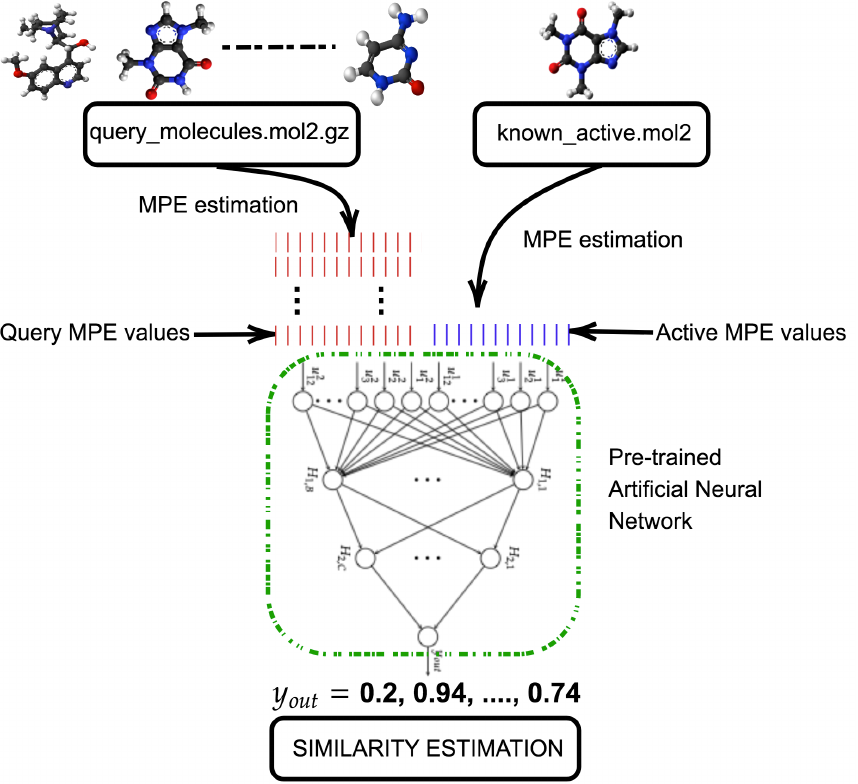
Figure 1. The process of similarity comparison between a set of query compounds with unknown chemical properties and a compound with known activity against a specific therapeutic